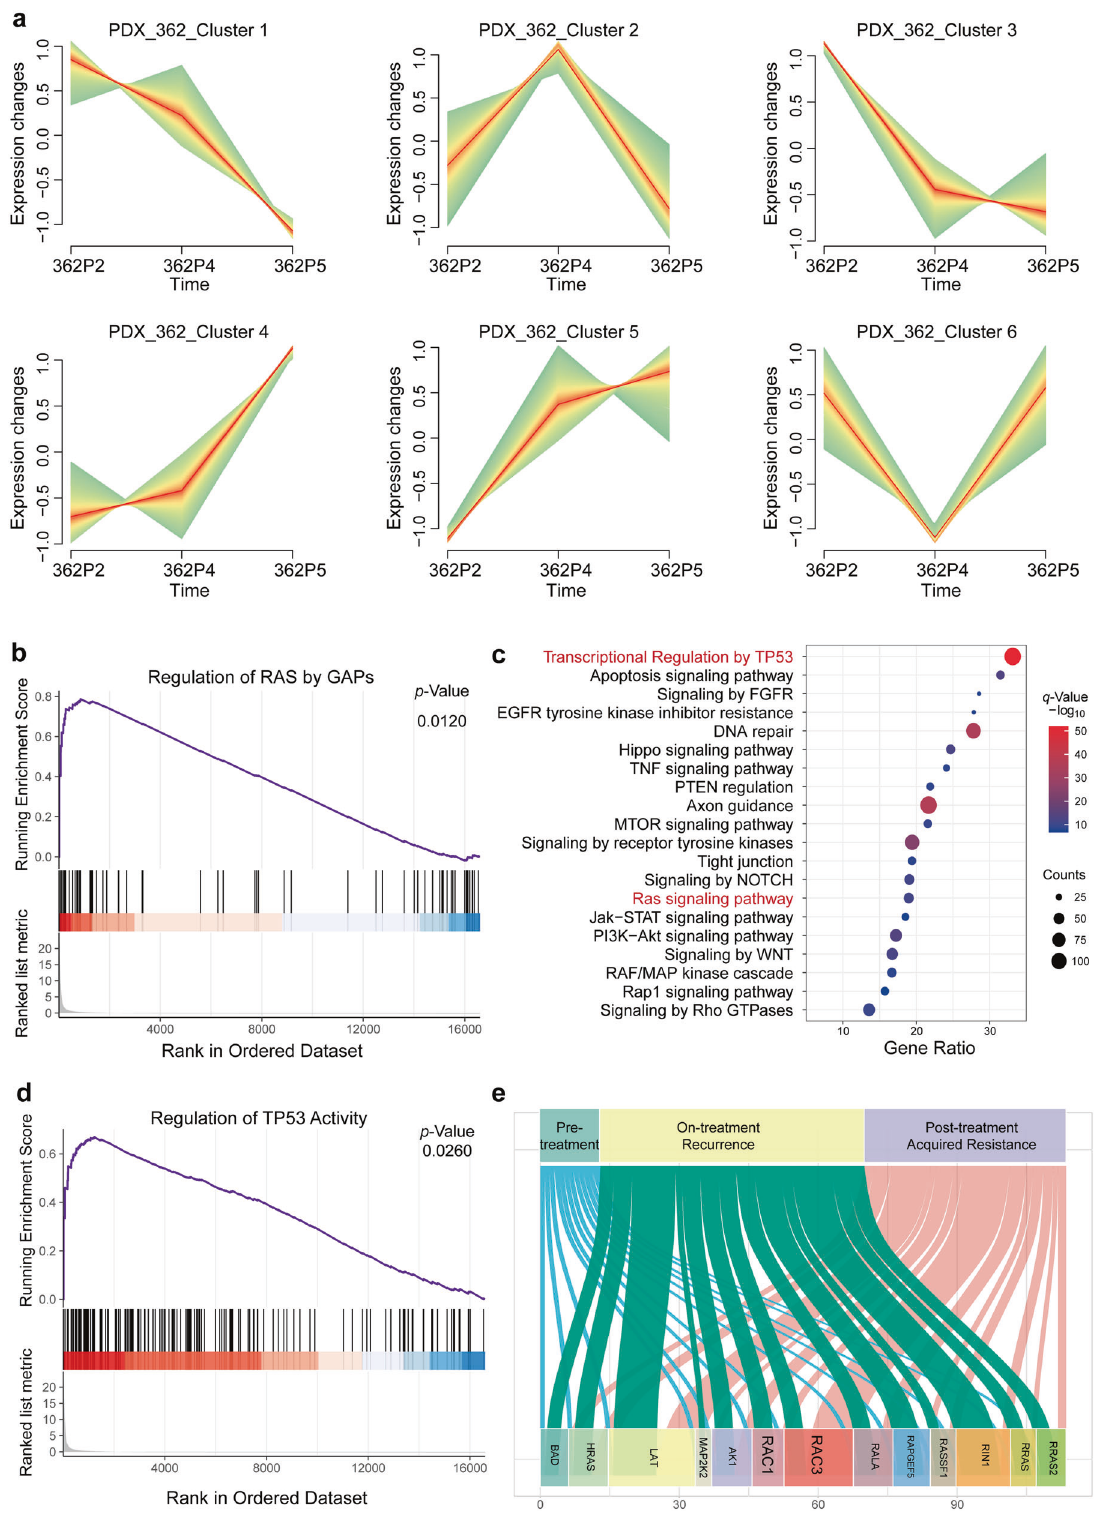
Fig. 6 Transcriptional dynamic analysis of acquired resistance to cetuximab. a Clustering genes by similar expression pro fi les in PDX_362 for time-series samples. b , d Gene set enrichment analysis (GSEA) was performed for transcript abundance for post-treatment versus pre- treatment: the differentially expressed genes displayed enrichment for the regulation of RAS by GAPs gene sets and regulation of the TP53 activity gene sets. c Gene ontology (GO) analysis of differentially expressed genes in post-treatment versus pre-treatment samples. e Sankey diagram illustrating changes of the expression components in the RAS signaling pathway through cetuximab treatment